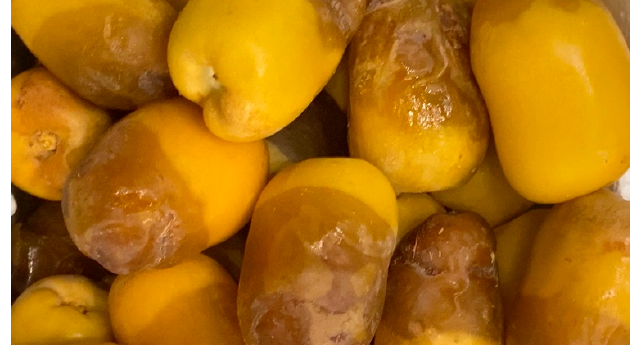
Figure 18. Sample of Salma dates. Figure 17. Sample of Al-muraaya dates.